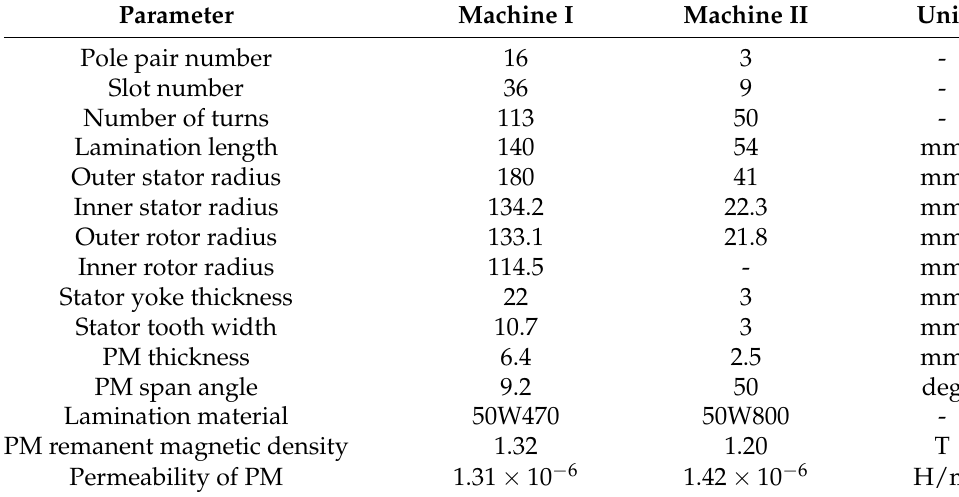
Table 1. Main design specification of the machines.